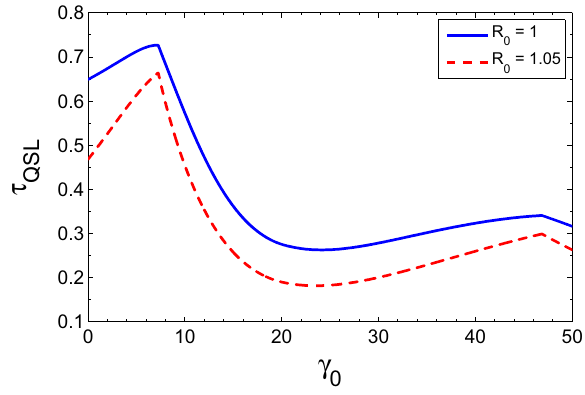
Fig. 5 The QSL-time for the damped Jaynes-Cummings model as a functionofthecouplingstrenght γ 0 .Thevalueofdrivingtimeis τ D = 1, initial time τ = 0 and Ω = 10